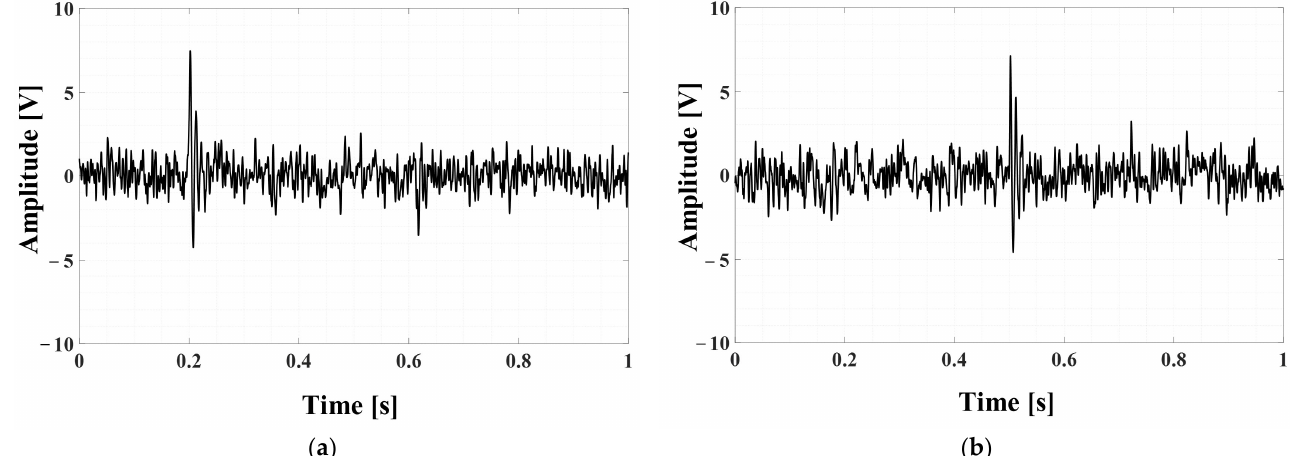
Figure 9. Time signal obtained after the optimal bandpass fi lter process: ( a ) using signal x(t) and ( b ) using signal y(t).